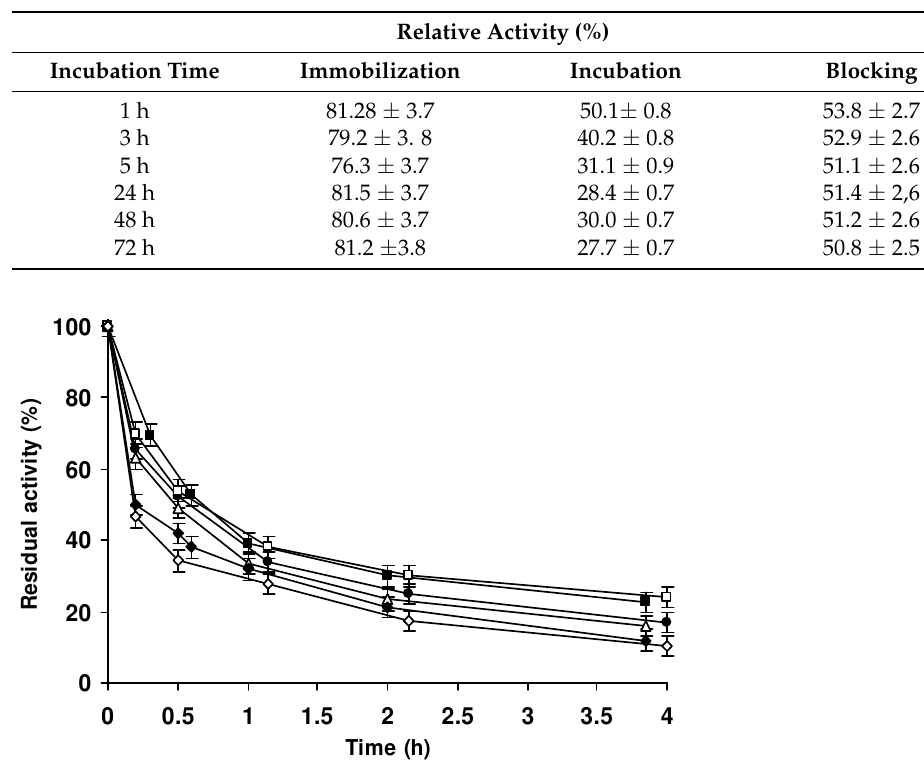
Table 5. Effect of the blocking agent (2 M) in the relative hydrolytic activity (considering 100% of the initial activity utilized in the immobilization) of PGA biocatalysts immobilized at pH 7 and incubated for 5 h at pH 10.0. The experiments were conducted as described in the Methods Section. Relative Activity (%) Blocking agent